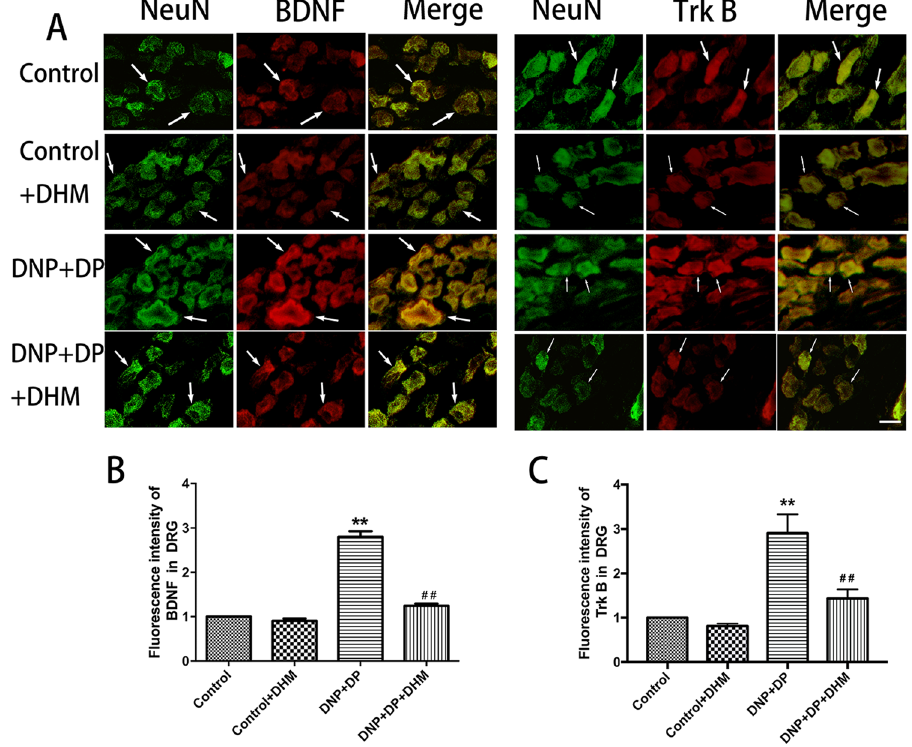
Figure 5. Co-expression of NeuN-BDNF ( A , B ) and NeuN-TrkB ( A , C ) in the DRG was detected with double- labelled immunofluorescence. Values are the mean ± SEM of 3 observations. ** p < 0.01 vs . control group; ## p < 0.01 vs . DNP + DP group. Scale bar: 20 μ